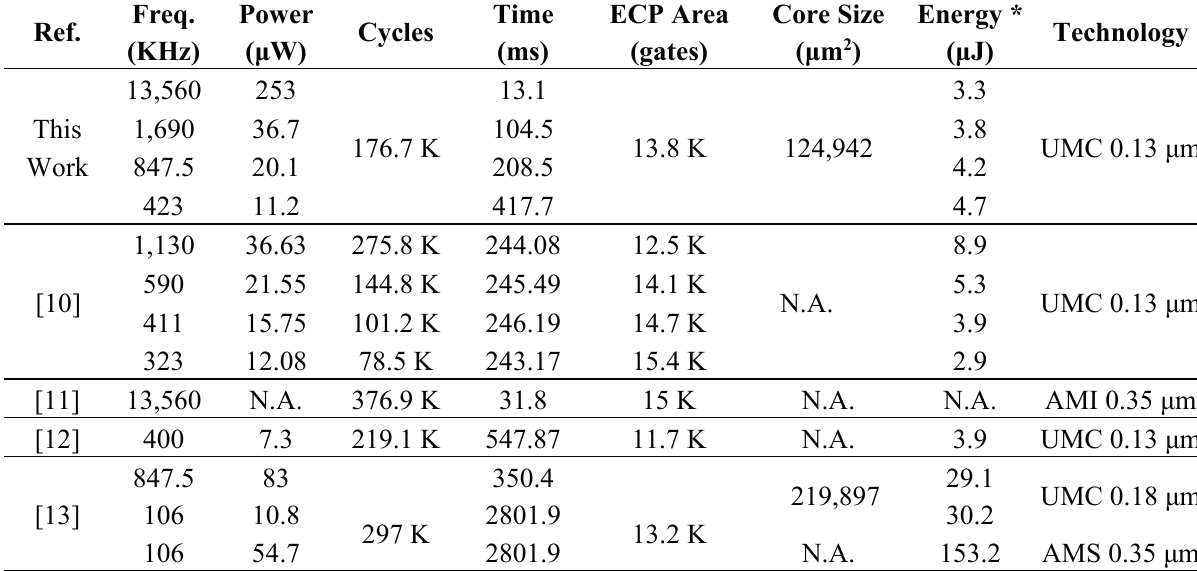
Table 3. Comparison with related